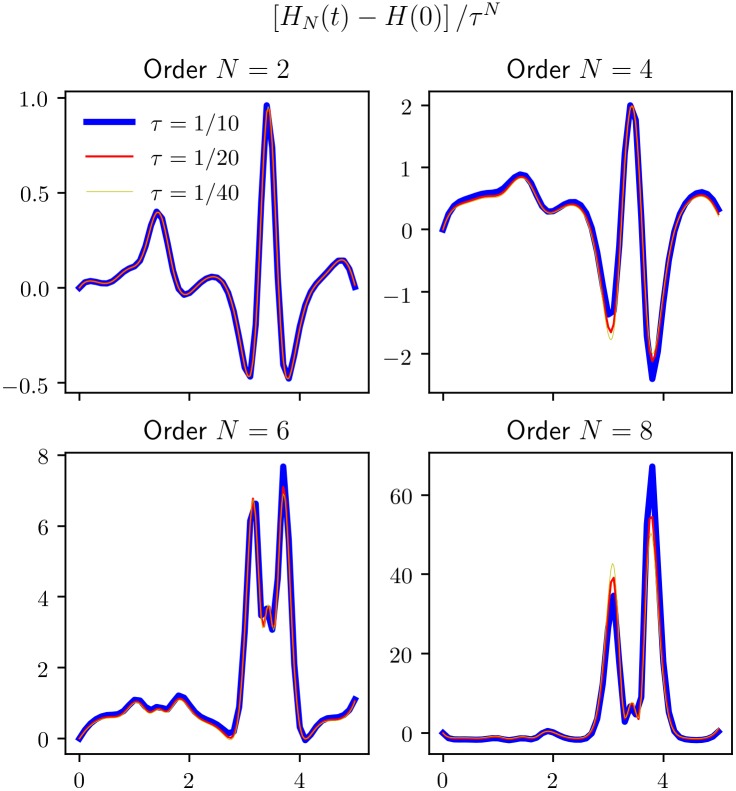
Scaled energy errors for some higher order symplectic integrators, when applied to the reduced 3-site Toda lattice Hamiltonian of Eq (11).The plots are for an orbit z(t) with initial value (0.1, 0, 0.1, 1.40709), corresponding to H0 = 1, C3⊥ = −6.45412, computed with KiMoKi solvers of orders N = 2, 4, 6, 8, and timesteps τ = 0.025, 0.05, and 0.1.